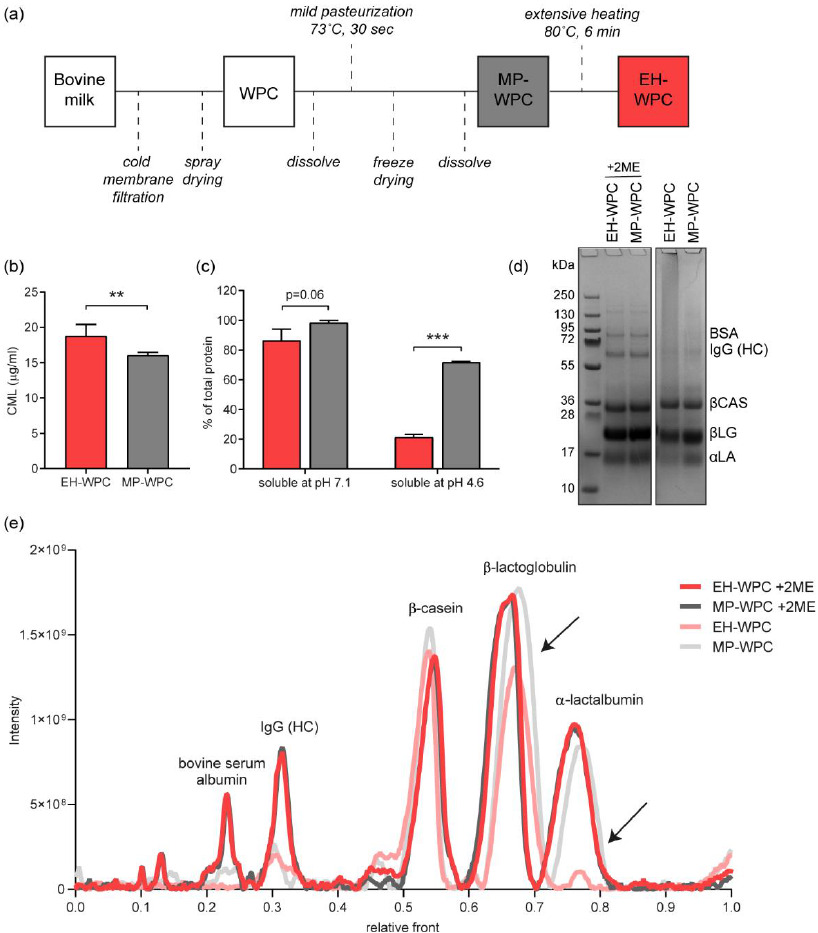
Figure 1. Whey protein processing. ( a ) Whey protein concentrate (WPC) was obtained from raw bovine milk by cold membrane filtration. The WPC was first mildly pasteurized for 30 s at 37 ◦ C, after which a part of the WPC was extensively heat-treated for 6 min at 80 ◦ C. ( b ) The level of carboxymethyllysine (CML, µ g / mL) measured by ultra-fast liquid chromatography / fluorescence UFLC / Flu) in both mildly pasteurized (MP-WPC) and more extensively heated WPC (EH-WPC). ( c ) Soluble protein (% of total WPC protein) at pH 7.1 and pH 4.6, determined by the DUMAS method. ( d ) Representative sodium dodecyl sulphate-polyacrylamide gel electrophoresis (SDS-PAGE) gel of EH-WPC and MP-WPC at pH 7.1 under reducing ( + 2ME) and non-reducing conditions, with ( e ) corresponding densitometric analysis. Black arrows indicate decrease in peak intensity for EH-WPC specifically. n = 3, ** p < 0.05, *** p < 0.01 based on t-test between EH-WPC and MP-WPC. BSA = bovine serum albumin, IgG (HC) = immunoglobulin G (heavy chain), β CAS = β -casein, β LG = β -lactoglobulin, α LA = α -lactalbumin. kDa = kilodaltons, 2ME =